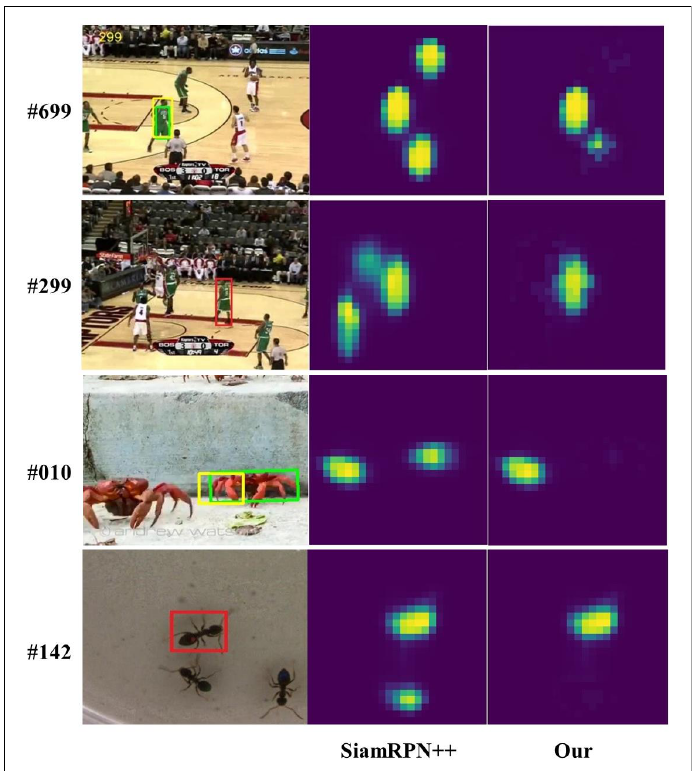
Figure 6. Comparison of response plots with SiamRPN++